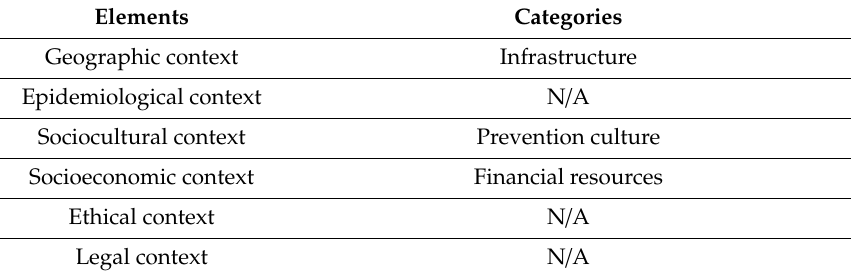
Table 6. Combination of inductive and deductive